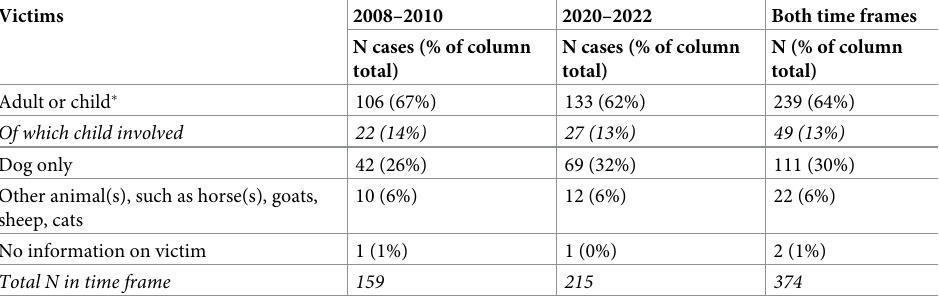
Table 4. Descriptive data on victims involved in dog biting incidents preceding confiscation of 374 dogs. Descrip- tive data on victims of biting incidents involved in biting incidents preceding confiscation of 374 dogs, presented as counts and as % of column total for a first time frame (2008–2010), a second time frame (2020-mid-May 2022) and overall for both time frames.